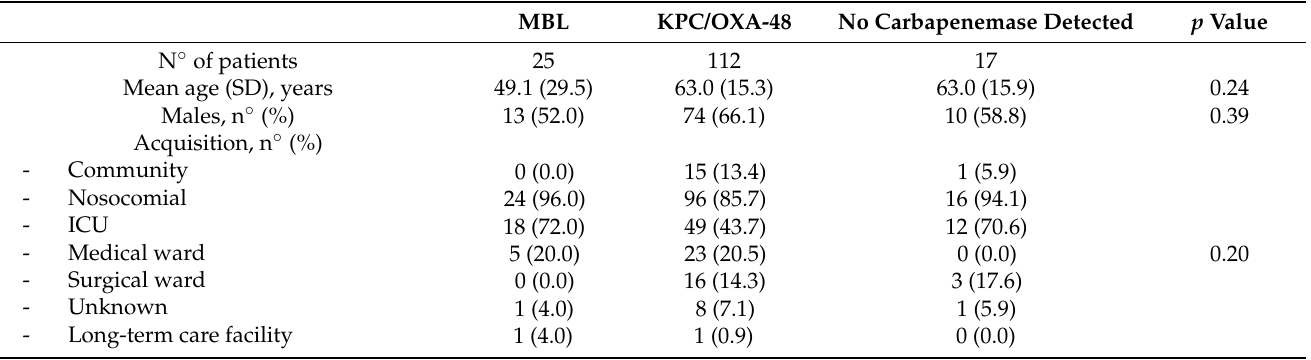
Table 2. Demographic, clinical and microbiological characteristics of the patients according to the carbapenemase